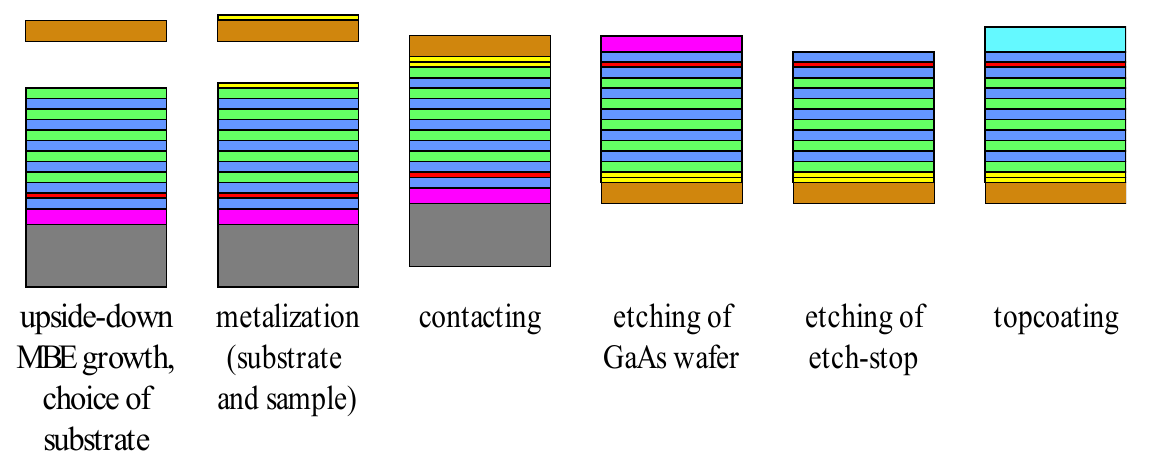
Figure 13. Schematic of the fabrication steps of future generation upside-down high-power